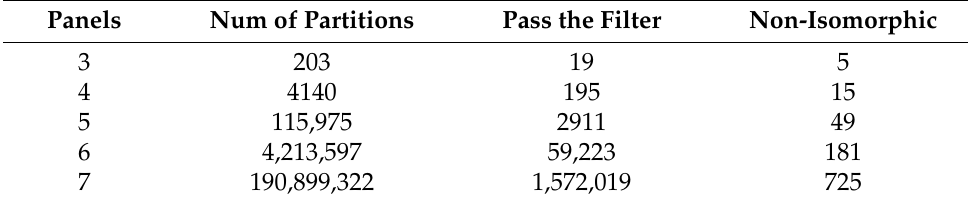
Table 1. Results of the filter